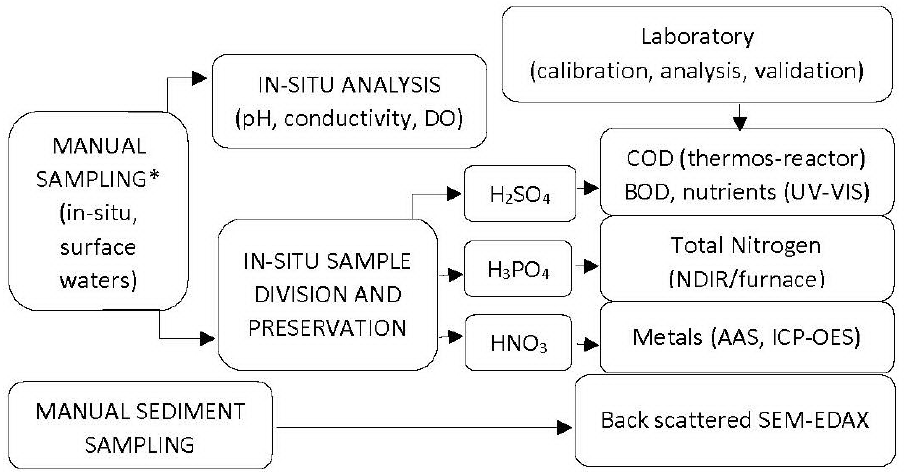
Figure 2. Applied methodology. Note: * in accordance with ISO 5667-6. Surface sediment samples were taken from river banks, in a column of maximum 2 cm, with a manual sampler and stored in 50 mL recipients. During transportation and